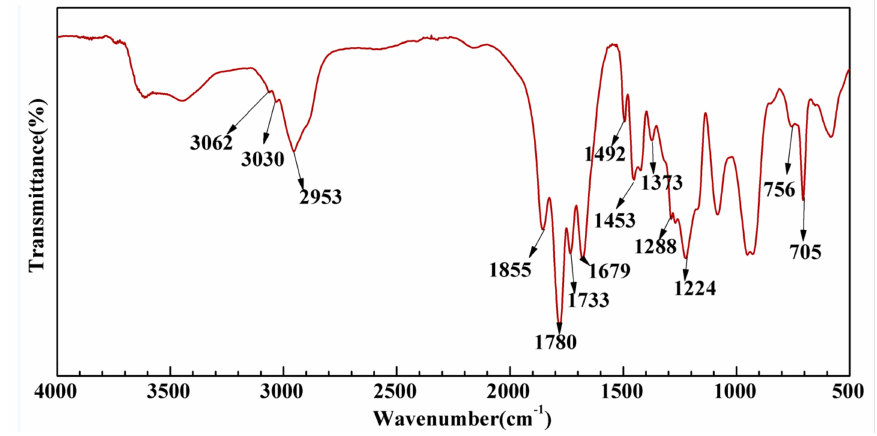
Figure 3. Infrared spectra of PMA- b -P (NVP/MAH/St) amphiphilic block